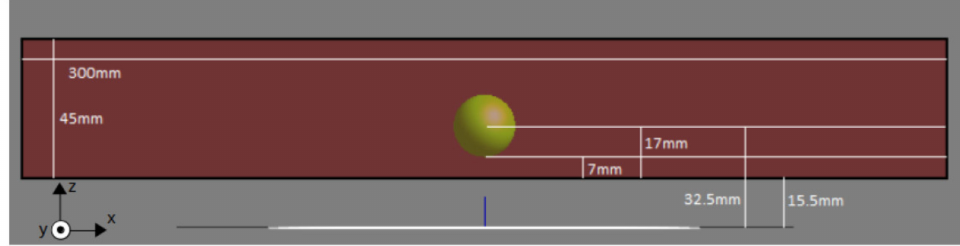
Figure 1. Phantom dimensions and tumor positioning (yellow circular area) at the center of the